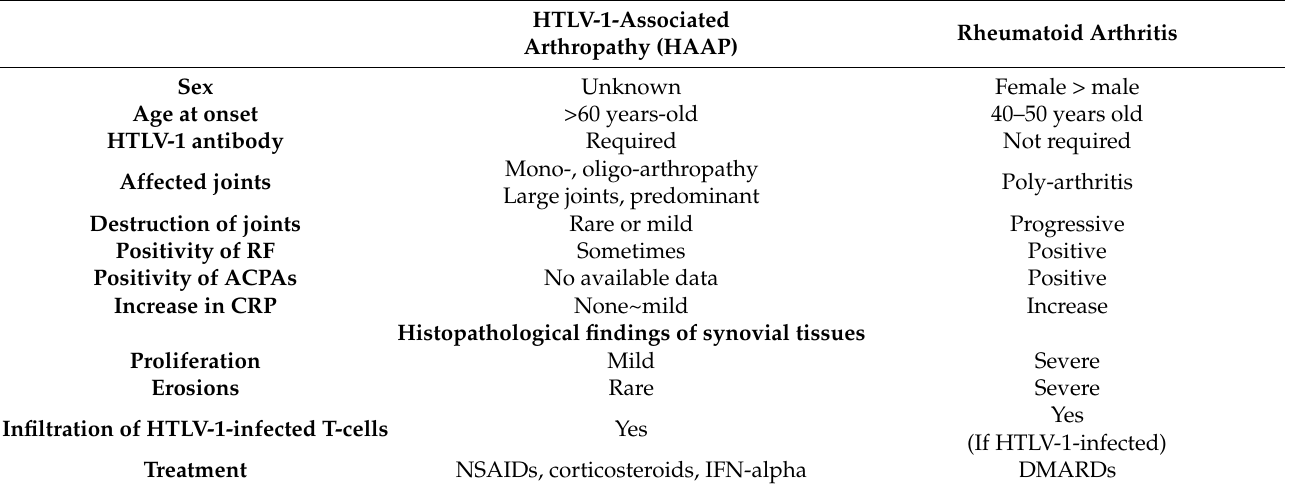
Table 1. Comparison of clinical manifestations between patients with HTLV-1-associated arthropathy and those with rheumatoid